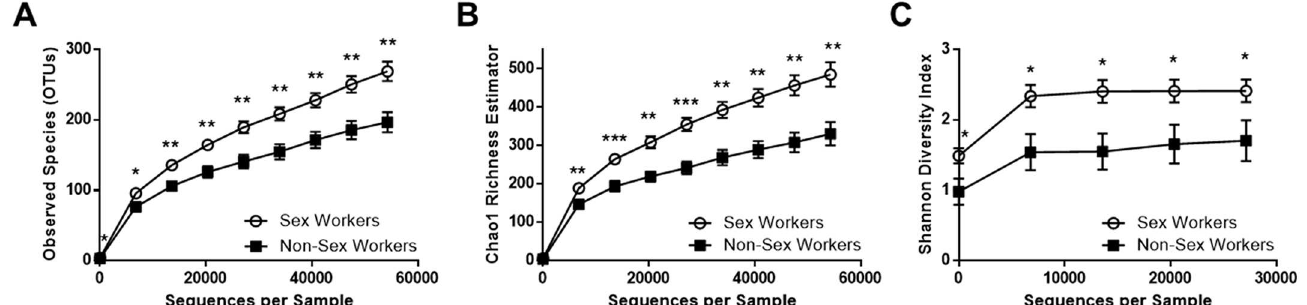
Fig 1. Non-Sex workers have less bacterial diversity in their vaginal microbiota than sex workers. Three alpha-diversity metrics were used to compare bacterial richness and diversity within the vaginalmicrobiotaof Non-Sex Workers (NSW, N = 19) as comparedto Female Sex Workers (FSW, N = 48) living in the same geographicallocation.NSW had a significantly less operationaltaxonomic units (OTUs, an approximation of the numberof observed species) than FSW when sequenceswere rarefied to a depth of 10, 13572,20353, 27134, 33915,40696, 47477, and 54288sequencereads (A). The Chao1 estimated bacterialrichness was found to be significantly less in NSW than FSW at 6791, 13572,20353, 27134, 33915,40696, 47477, and 54288 sequencereads (B). The ShannonDiversity Index was also significantly lower in NSW than FSW at 10, 6791, 13572, 20353, and 27134 sequencereads (C). NSW (black squares), FSW (open circles). * : P < 0.05, ** : P < 0.01, *** P < 0.001. Data is presentedas mean ±